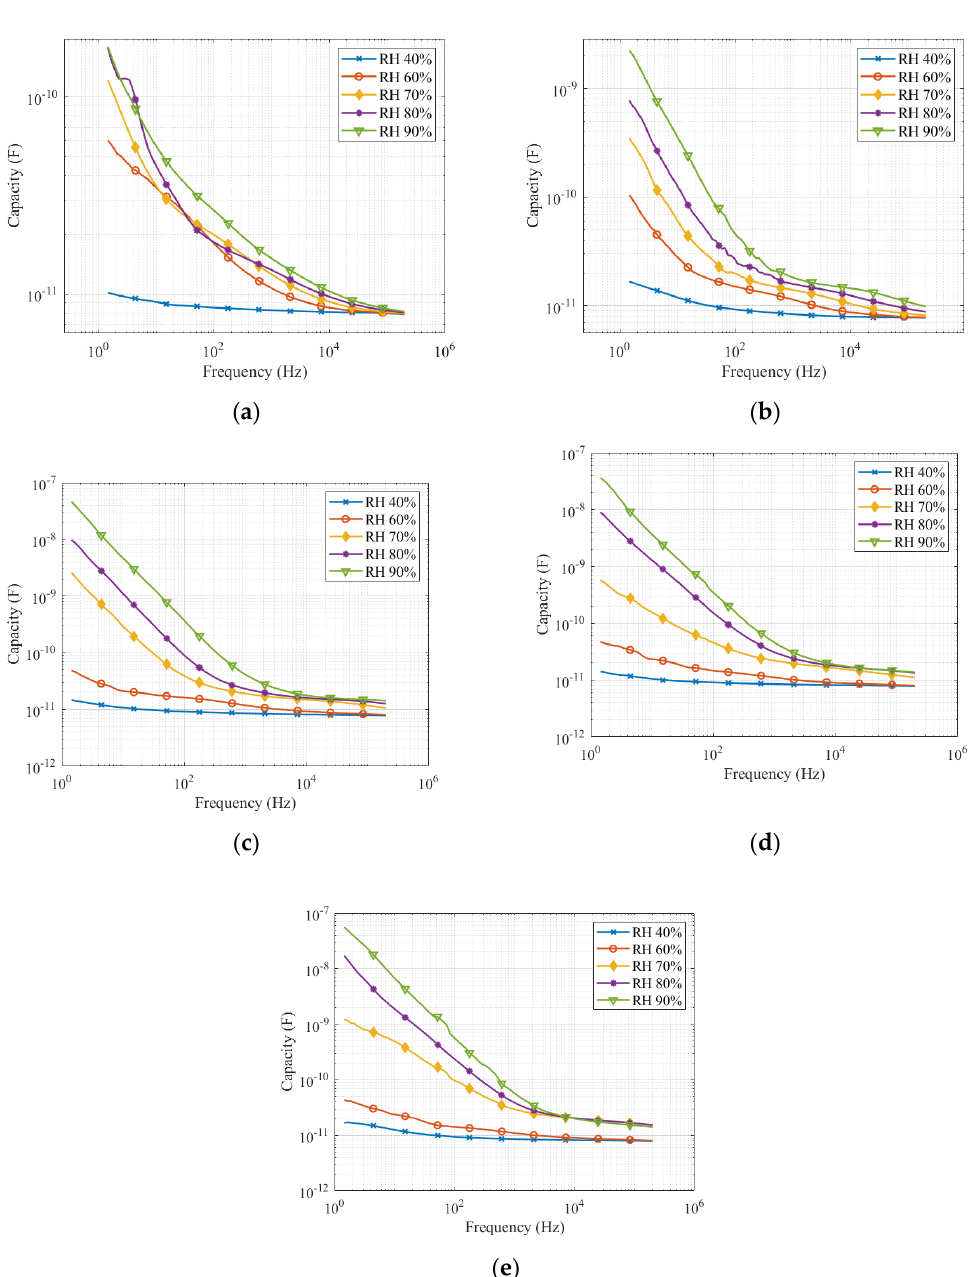
Figure 8. Capacity in the frequency range: ( a ) clear insulator; ( b ) first pollution level; ( c ) second pollution level; ( d ) third pollution level; ( e ) fourth pollution level.